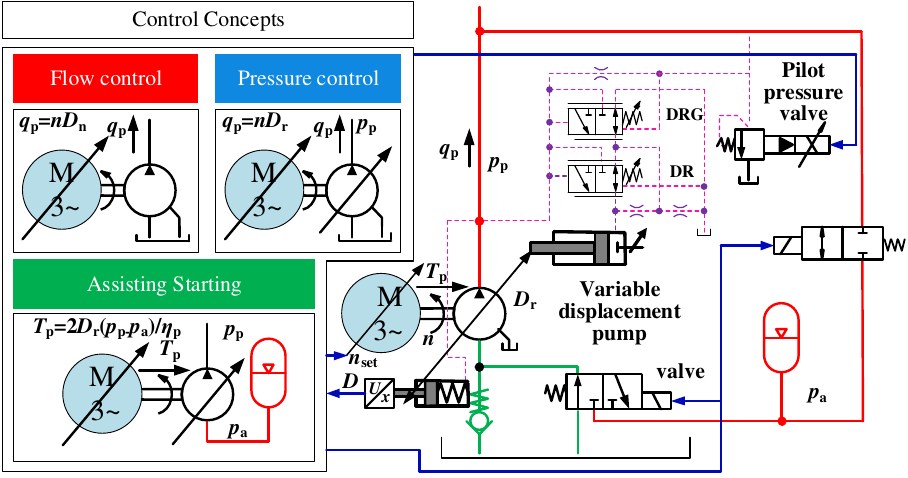
Figure 1. Principle of the electro-hydraulic power source.